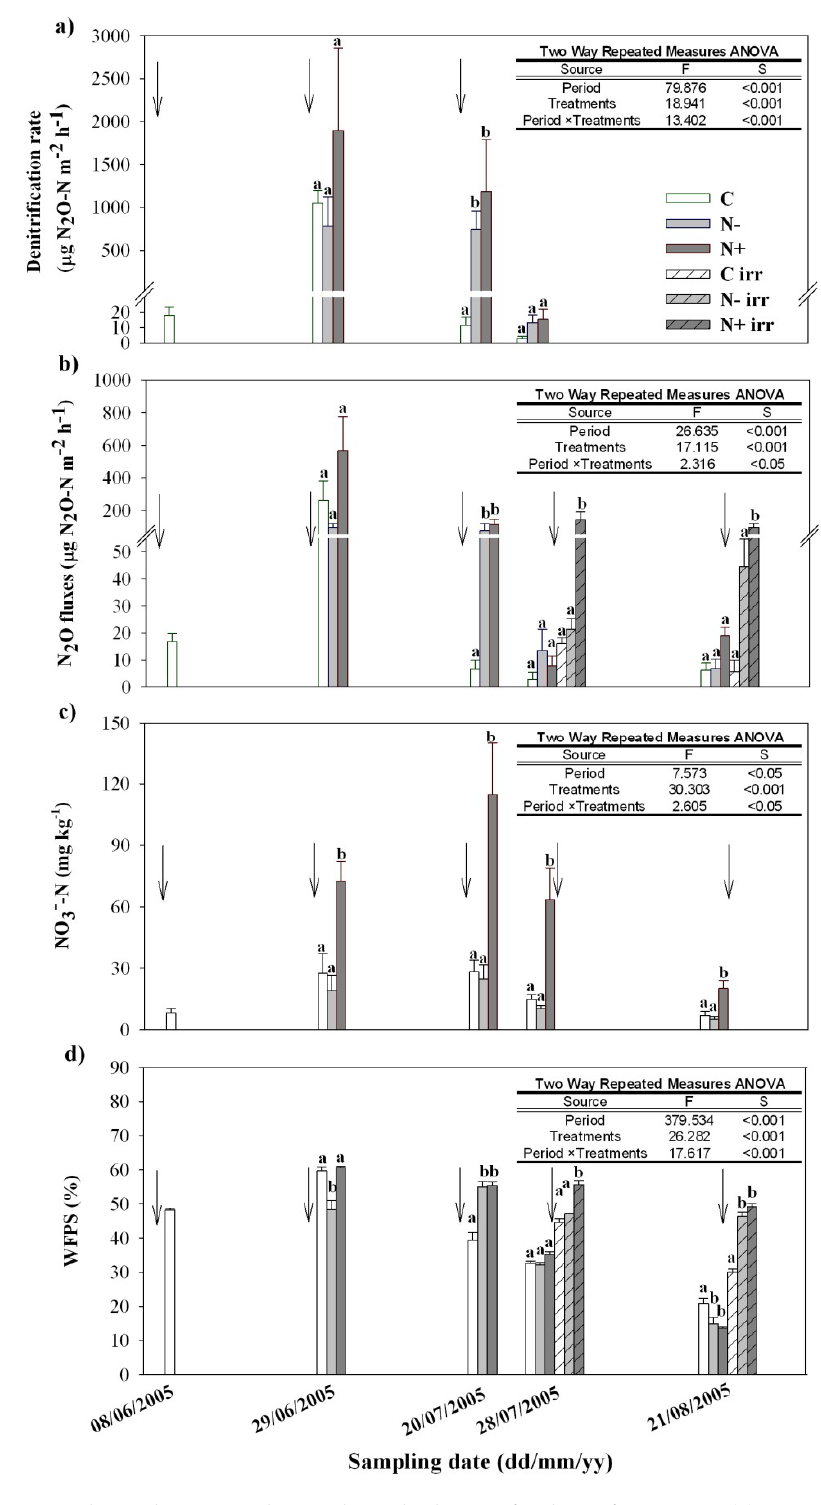
Figure 3. Figure shows the mean values and standard errors for denitrification rate ( a ), N 2 O fluxes ( b ), soil NO 3 − ( c ) and WFPS ( d ) in the course of the manipulation experiment during the Zea mays growth in 2005. The arrows indicate the irrigation events. The statistical results of the analysis of variance are shown in the inset tables. The di ff erent letters point out significant di ff erences between treatments on each sampling date (All Pairwise Multiple Comparison Procedures, Holm-Sidak method). The crossed bars indicate the N 2 O fluxes and the WFPS after irrigation events, on sampling dates when direct N 2 O emissions were recorded before and after water supply.